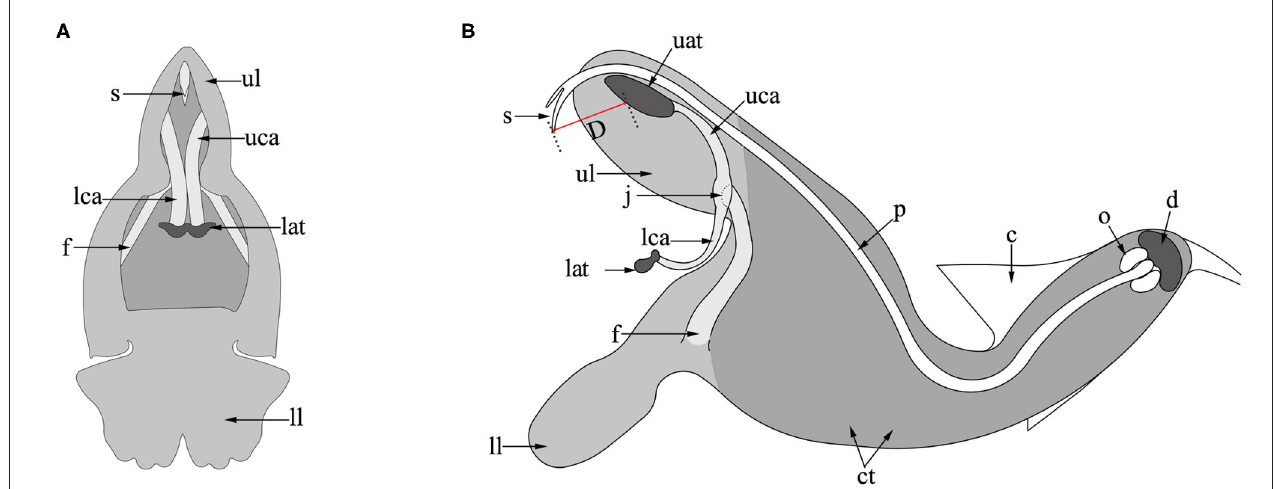
FIGURE 1 | Flower structure of S. umbratica. (A) Front view; (B) lateral view. ct, corolla tube; ul, upper lip; ll, lower lip; uat, upper anther theca; lat, lower anther theca; uca, upper connective arm; lca, lower connective arm; j, joint; f, filament; p, pistil; s, stigma; c, calyx; o, ovary; d, disc; D, distance (between the stigma and upper anther